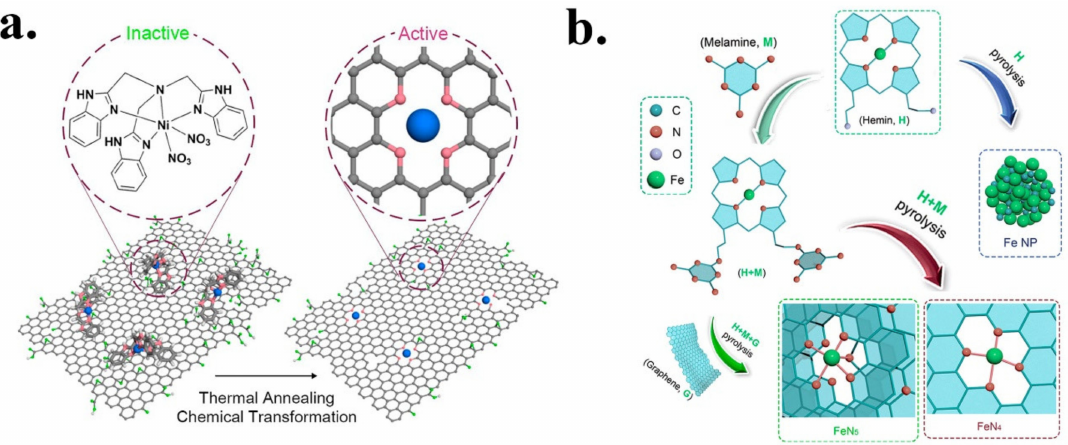
Figure 17. Synthesis methodologies for the immobilization of simple atoms using ligands. ( a ) Activation of adsorbed species on graphene oxide by thermal annealing (adapted from [101]) and ( b ) formation of the axial ligand coordinated with FeN 4 forming a new FeN 5 site (adapted from [110]).